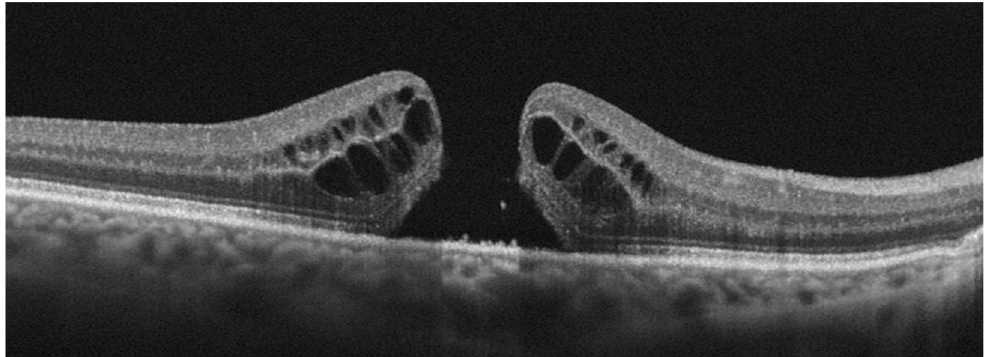
Figure 3. Optical Coherence Tomography (OCT) scan of a full-thickness macular hole associated with intraretinal cystoid spaces. Multiple hyporeflective cystoid spaces are located in both the inner nuclear layer and the outer nuclear layer.